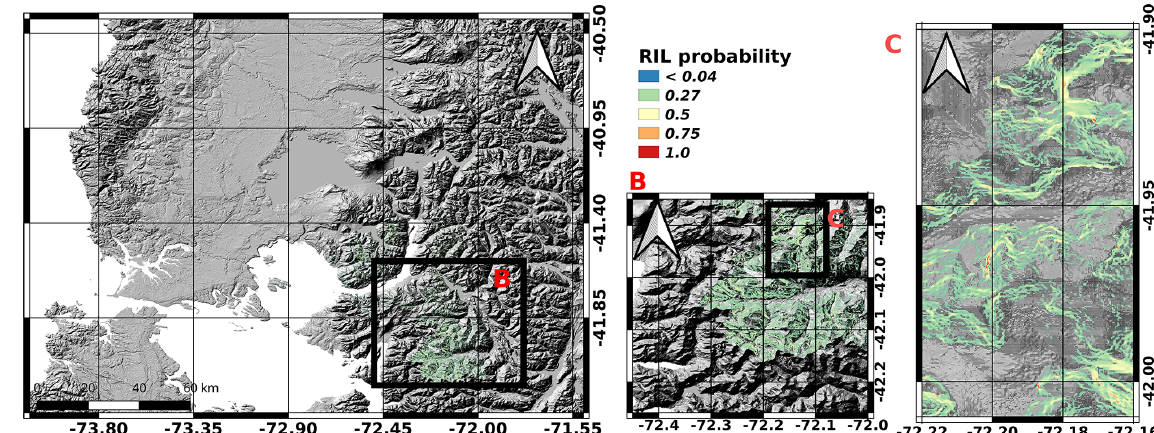
Figure 9. Zones susceptible to RILs for 8 January 2017. Results using Model 1 (logit). Hillshade based on SRTM data.